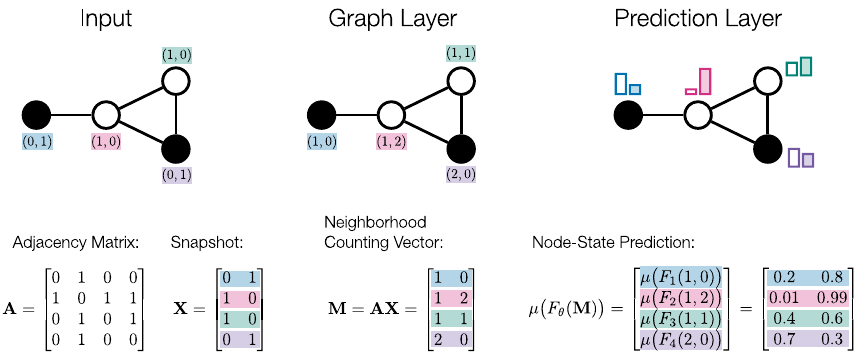
Fig. 2 Schematic architecture using 4-node graph with S = { ( 0,1 ) , ( 1,0 ) } . Nodes are color-coded, node-states are indicated by the shape (filled: I , blank: S ). First, we compute m i for each node v i (stored as M ), then we feed each m i into a predictor that predicts the original